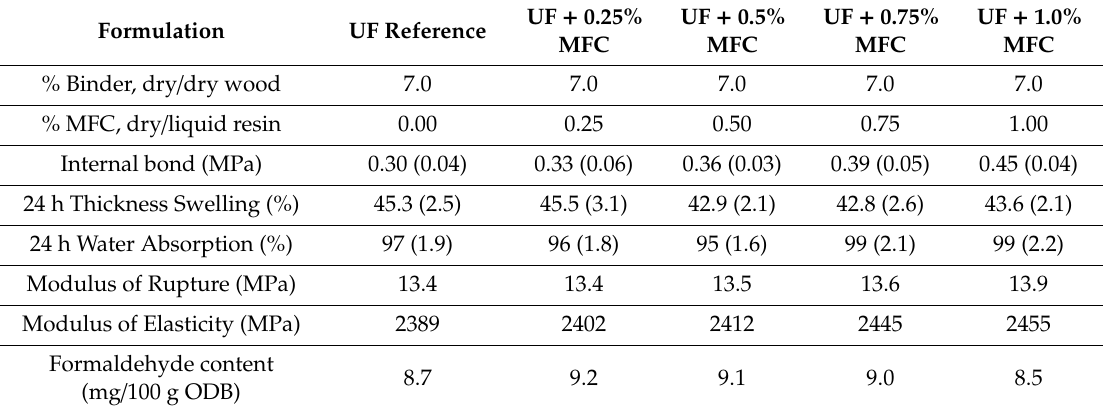
Table 3. Particleboard panels analysis, MFC 10% increasing levels, resin stable, Approach 2, Average property values, Standard deviation in brackets).